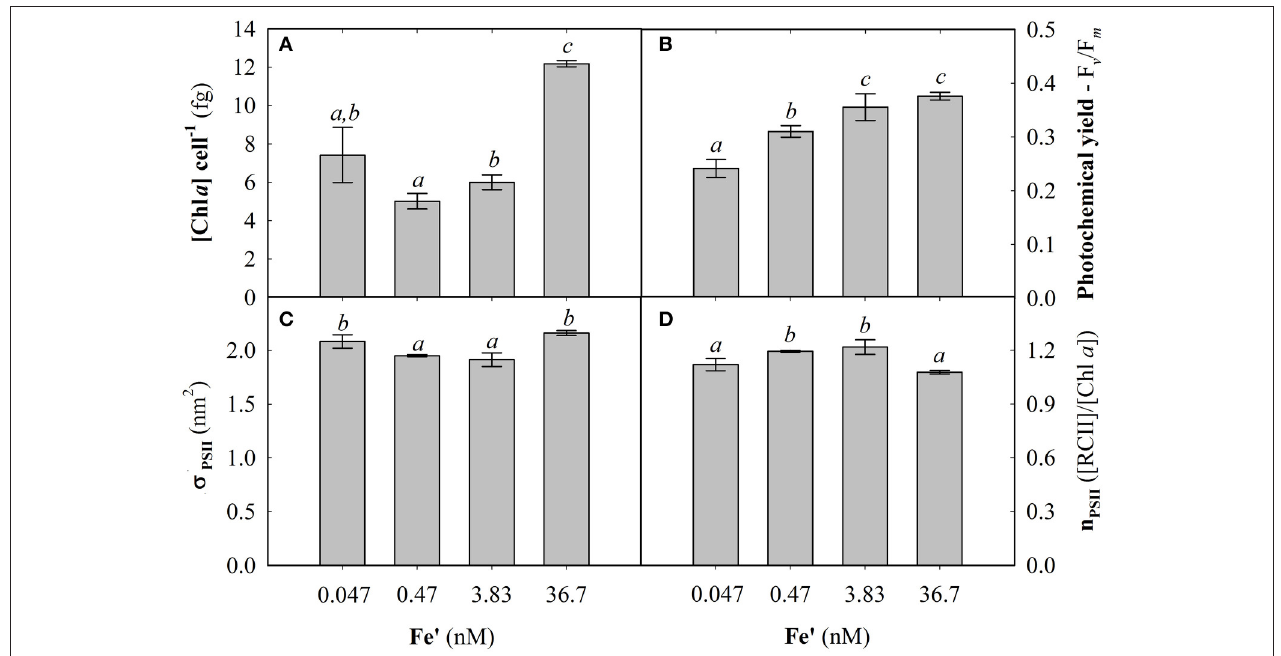
FIGURE 2 | Photophysiological changes in response to bioavailable iron (Fe) in the culture medium. (A) Cellular concentration of chlorophyll a (Chl a ). (B) Maximum photochemical yield. (C) Functional absorption cross-section of photosystem II (PSII). (D) Photosynthetic unit size of PSII. Letters indicate no statistical significant difference amongst treatments ( P >